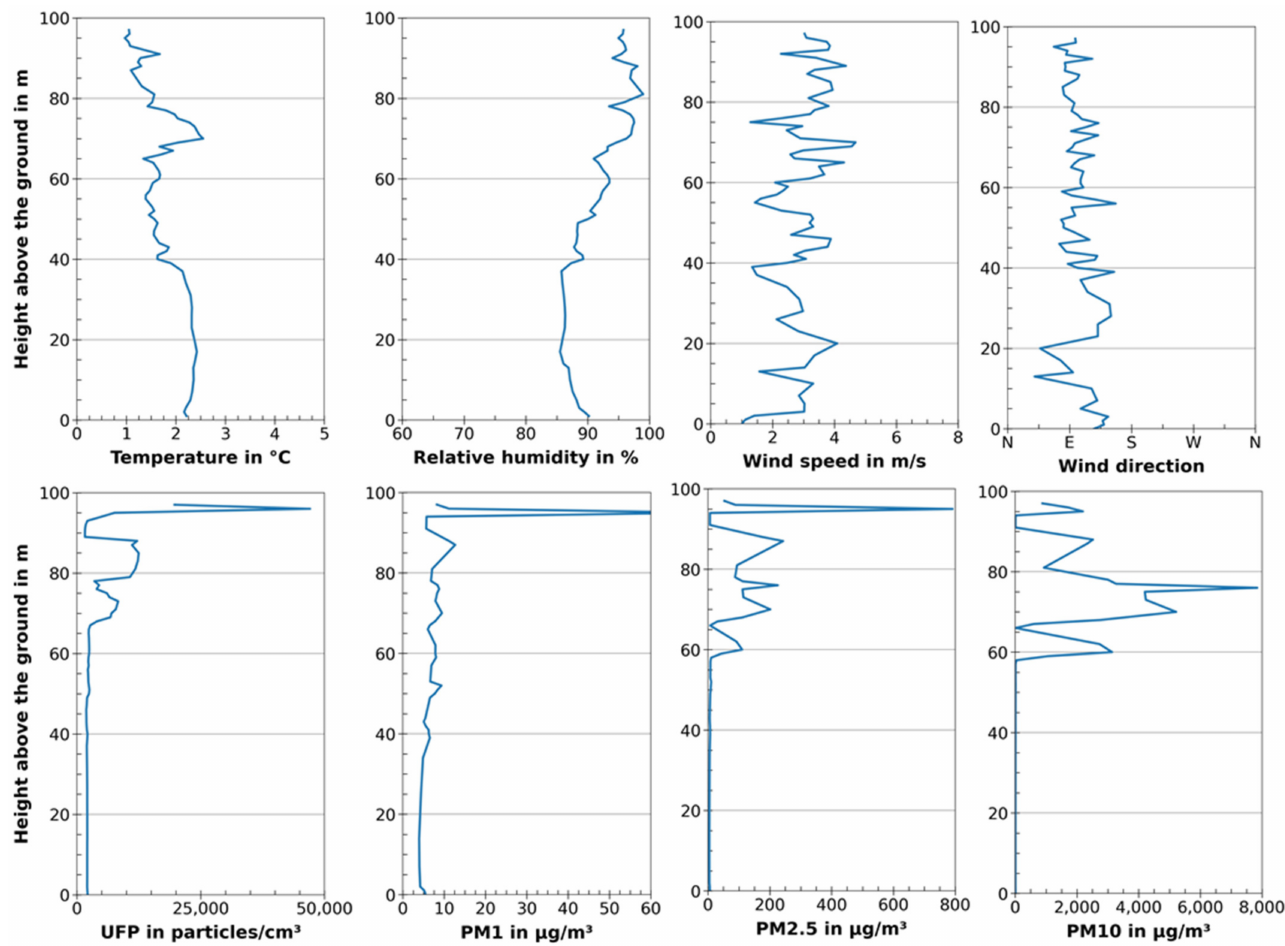
Figure 8. Vertical profiles of the meteorological parameters and air pollutants during the ascent at 12:08 local time on 31 January